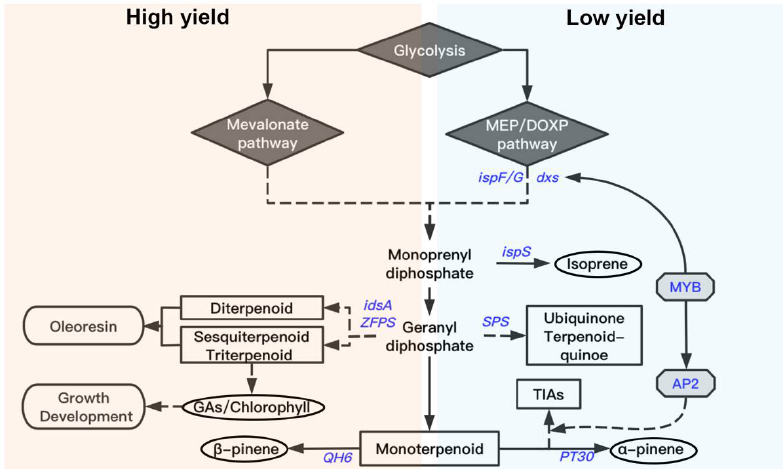
Figure 6. The proposed model of oleoresin biosynthesis in slash pine.